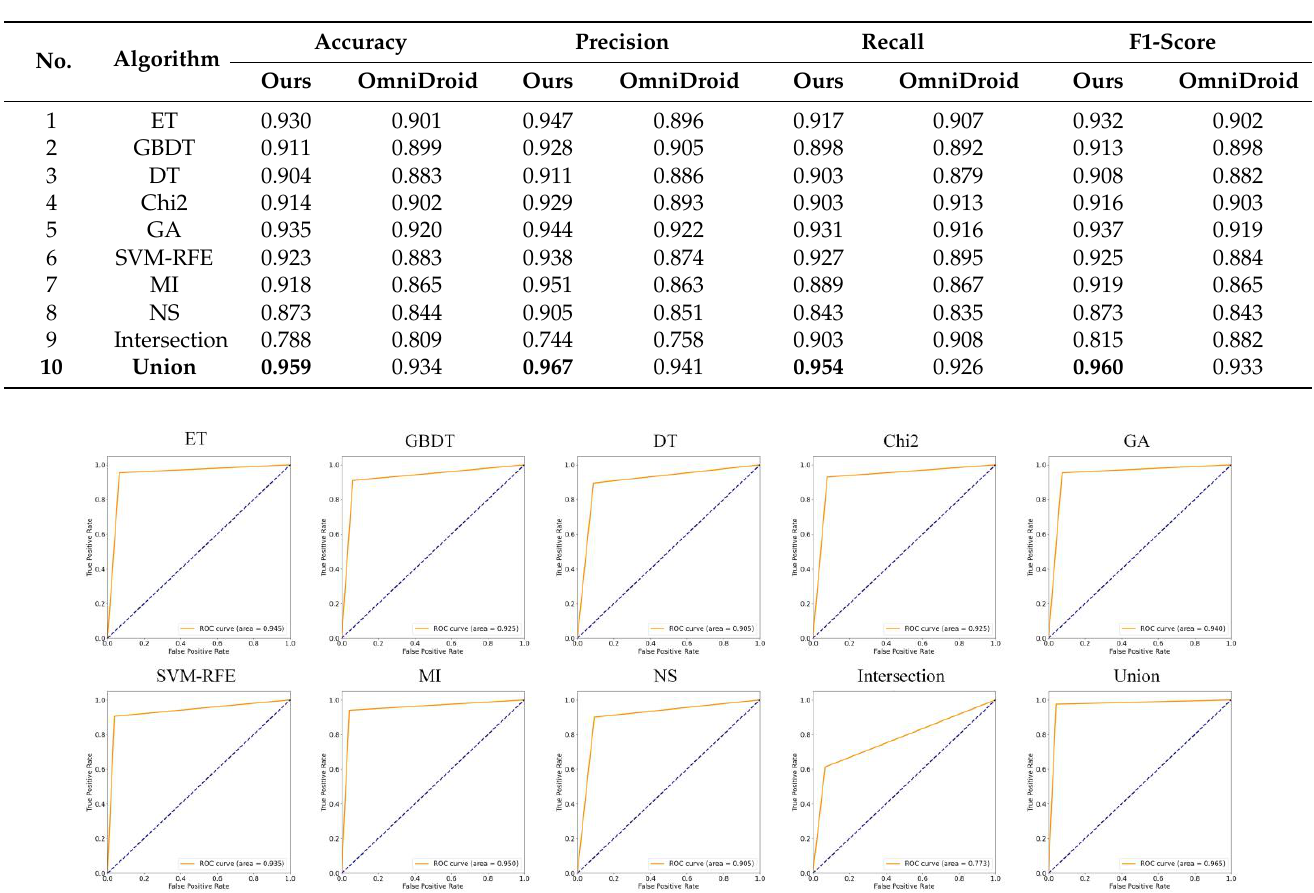
Figure 5. ROC curves of different feature selection methods on our dataset.